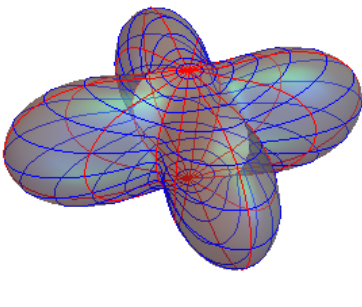
( Left ) The glyph represents the diffusion orientation distribution function. ( middle ) The glyph represents the ECP-inverse of this; and ( right ) another tensor glyph with its inverse is plotted together. For visual comparison, lines of longitudes are indicated in red and latitudes in